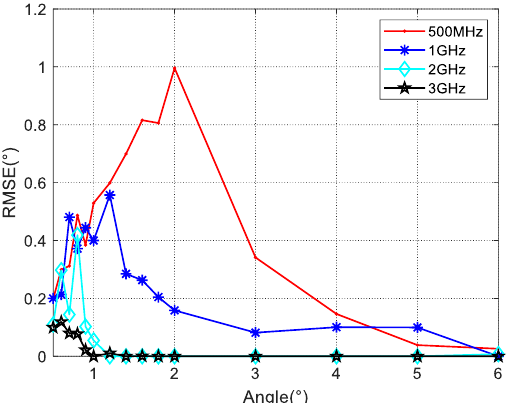
Figure 15. Sensors 2020 , 20 , 3104